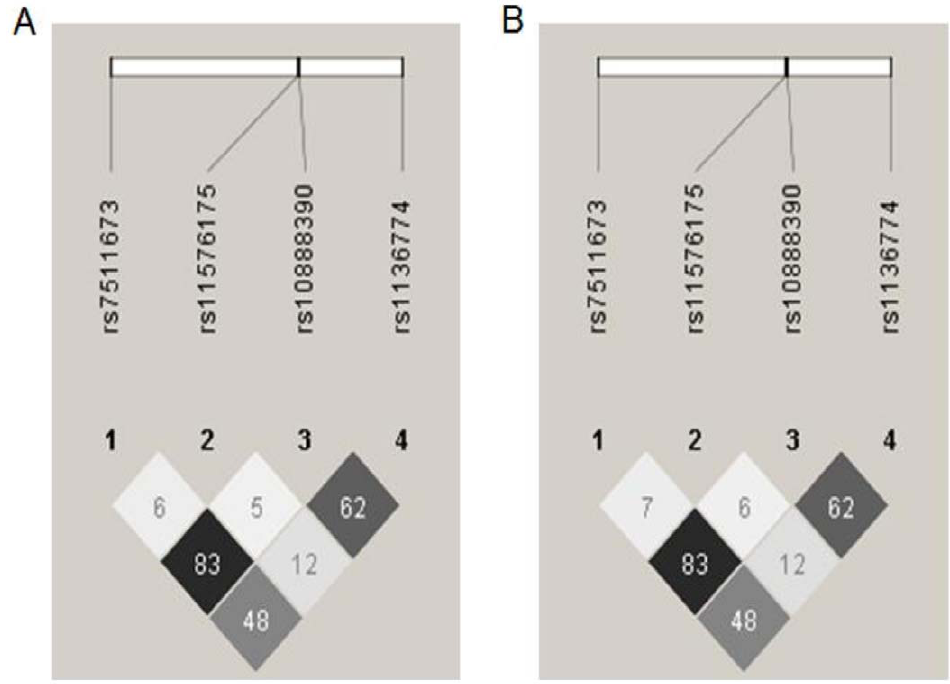
Figure 1. Linkage disequilibrium (LD) plot of the CTSS locus in cases and random subcohort. This Figure shows LD (linkage disequilibrium) values (r 2 ) between each tag SNP in (A) cases and (B) subcohort. Each diamond contains the LD value (r 2 ) between the two SNPs that face each of the upper sides of the diamond, ex: the LD between rs10888390 (SNP N u 3) and rs1136774 (SNP N u 4) is r 2 =0.62; the darker the diamond, the higher the LD value. There seems to be no difference in the LD pattern at the CTSS locus between the cases and the subcohort.